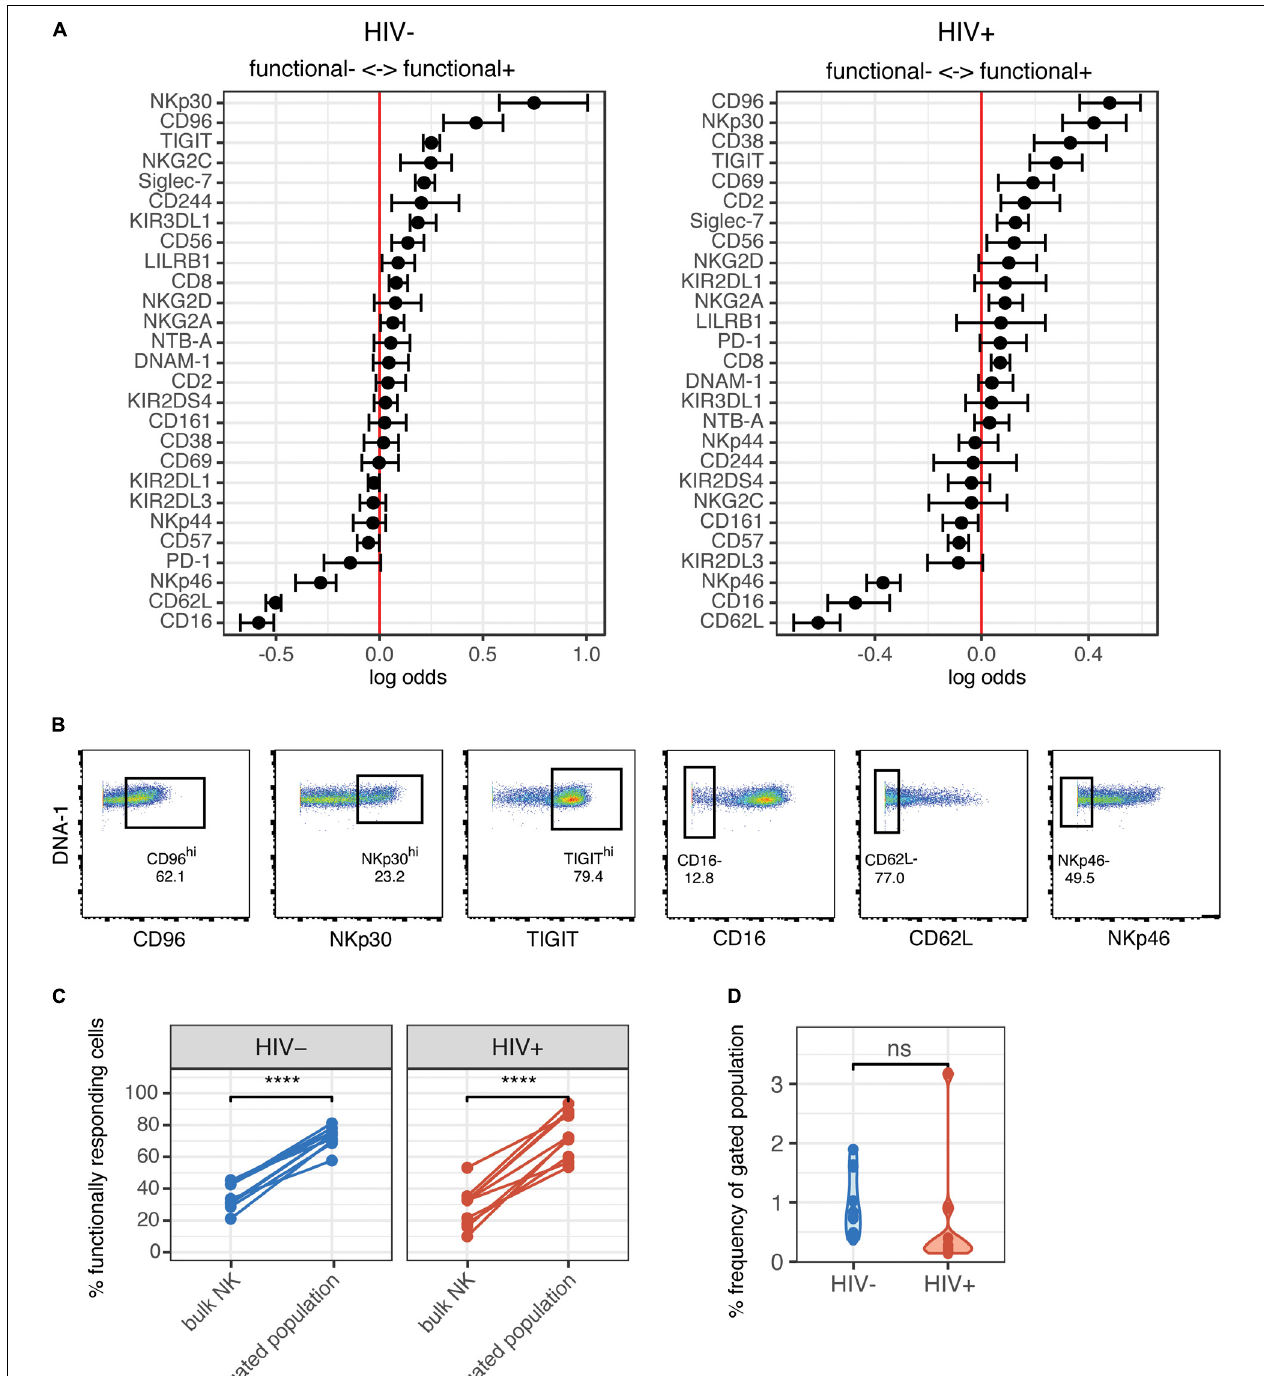
FIGURE 3 | Phenotype of NK cells responding to HIV are similar between HIV- and HIV+ donors, and include many of the markers that are altered in ART-treated HIV infection. (A) A generalized linear model with bootstrap resampling was used to identify NK cell receptors predictive of either functionally responding (right), or non-responding (left) NK cells, in HIV– ( n = 10) and HIV+ ( n = 10) donors. Log-odds are logarithm of ratios of the probability that a cell belongs to either group. For each marker, the 95% confidence interval is represented by the line surrounding the point estimate; a larger absolute log-odds value of the parameter indicates that the marker is a stronger predictor. (B) Gating on markers that predict functionally responding cells (NKp30 hi CD96 hi TIGIT hi CD62L - CD16 - NKp46 - ), with a minimum log-odds threshold of 0.2 in both groups. (C) Comparison of functional activity in the gated population, compared to bulk NK cells. Summary data of percentage positive functionally responding (positive for any of CD107a, IFN- γ , MIP-1 β , and TNF- α ) in HIV– ( n = 10) and HIV + groups ( n = 10). **** p < 0.001, by paired t -test. (D) Comparison of the frequency of the gated population, as a percentage of total NK cells, between the HIV– ( n = 10) and HIV+ ( n = 10) groups. ns, not significant, by t